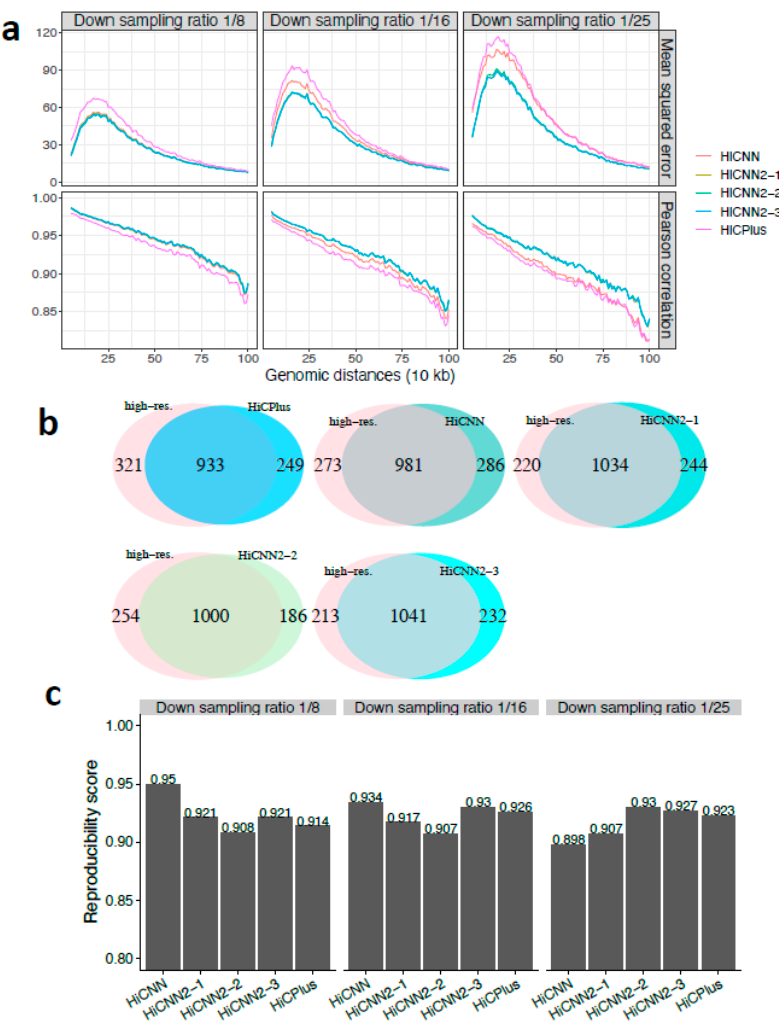
Figure 2. The evaluation results on chromosome 17 in human GM12878 cells between experimental high-resolution Hi-C (10 kb resolution) and each of the five predicted Hi-C data sets, namely, HiCPlus-enhanced, HiCNN-enhanced, HiCNN2-1-enhanced, HiCNN2-2-enhanced, and HiCNN2-3-enhanced: ( a ) mean squared error and Pearson’s correlations with three different down-sampling ratios (1/8, 1/16, and 1/25); ( b ) the effectiveness of recovering significant interactions (detected by Fit-Hi-C with q -value < 0.05) with the down-sampling ratio equal to 1/25; and ( c ) the reproducibility scores with the three down-sampling ratios.